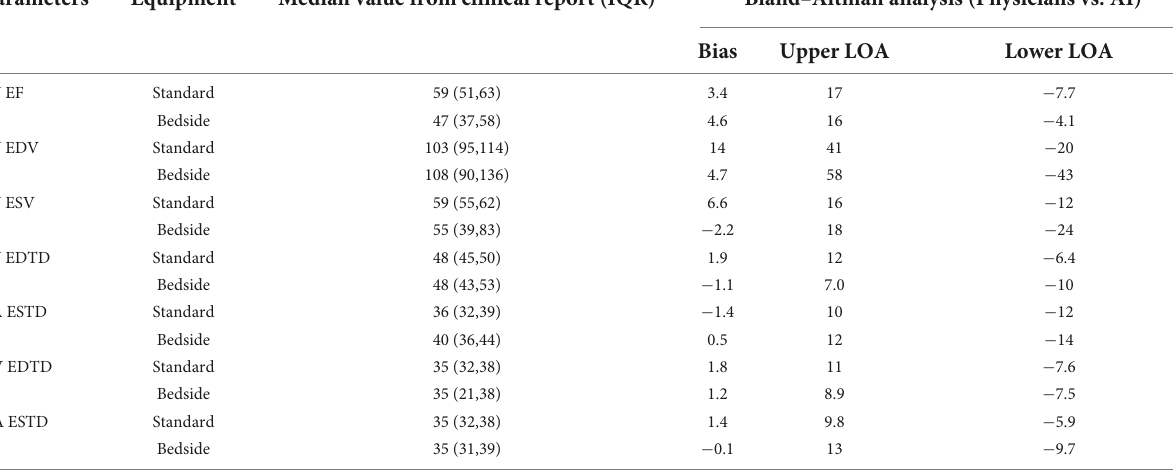
TABLE 4b The measurements of the corresponding clinical metrics for the RWMAs made by physicians and predicted by AI in external test dataset. Parameters